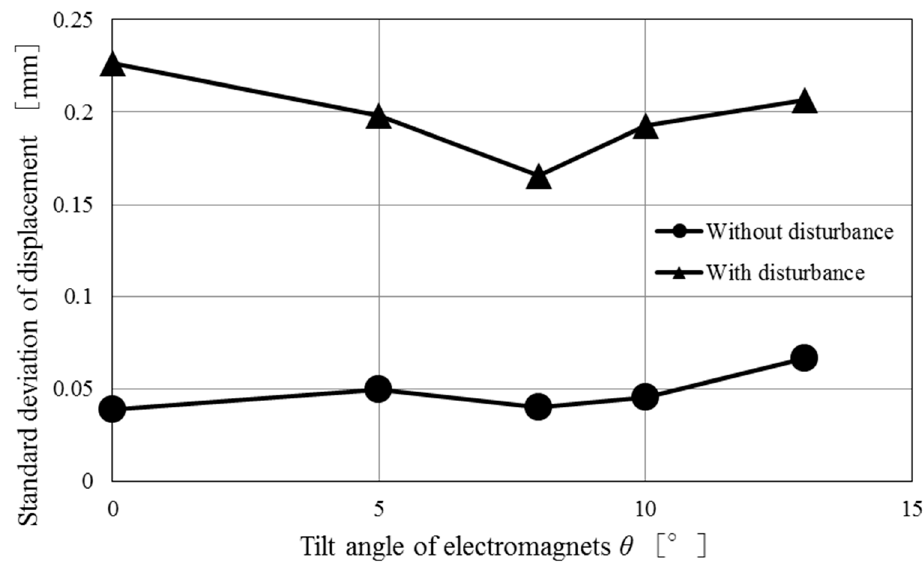
Figure 15. The relationship between the standard deviation of displacement and the electromagnet angle in cases with and without disturbances.